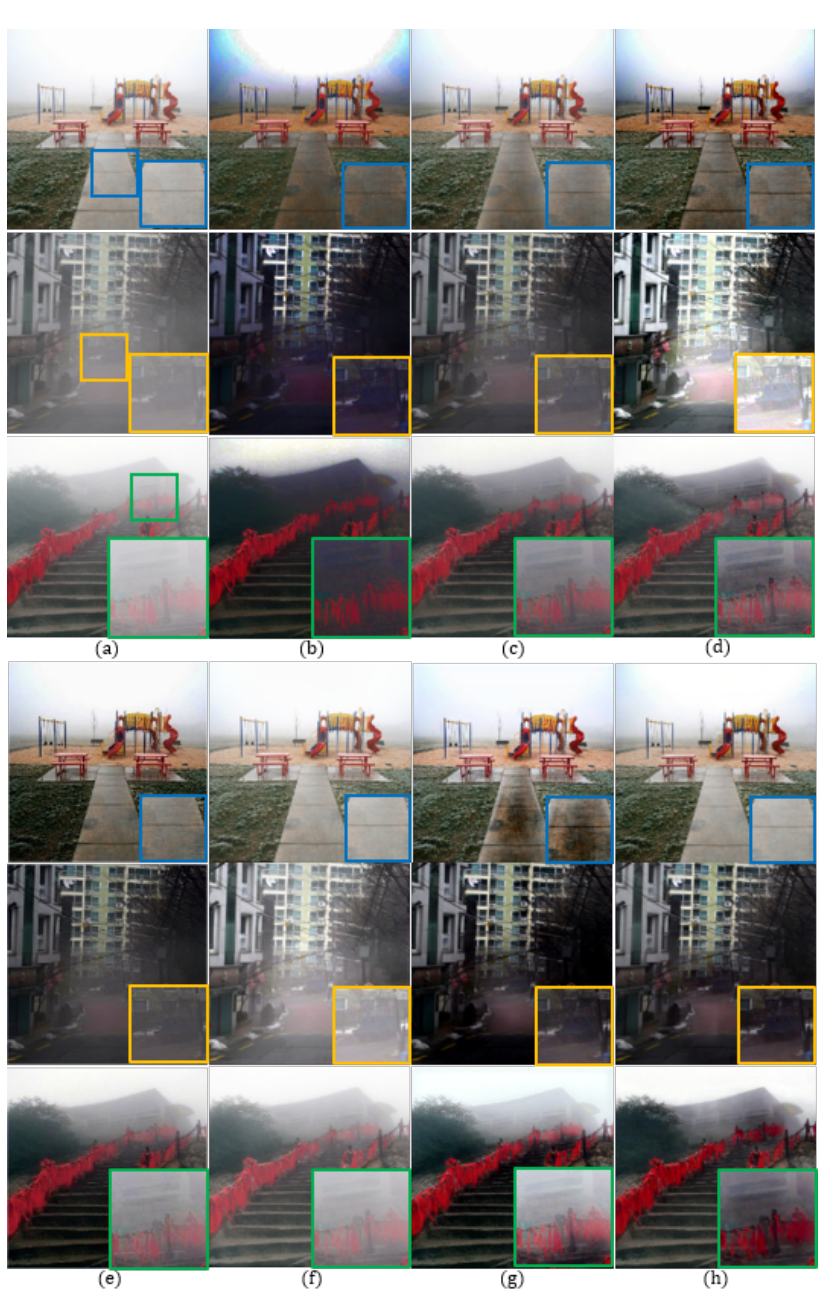
Figure 8. Subjective comparison of different dehazing methods using FADE [36]: ( a ) hazy input image, ( b ) DCP [9], ( c ) CAP [10], ( d ) RRO [4], ( e ) AOD [37], ( f ) DCPDN [17], ( g ) GFN [18], and ( h ) the proposed